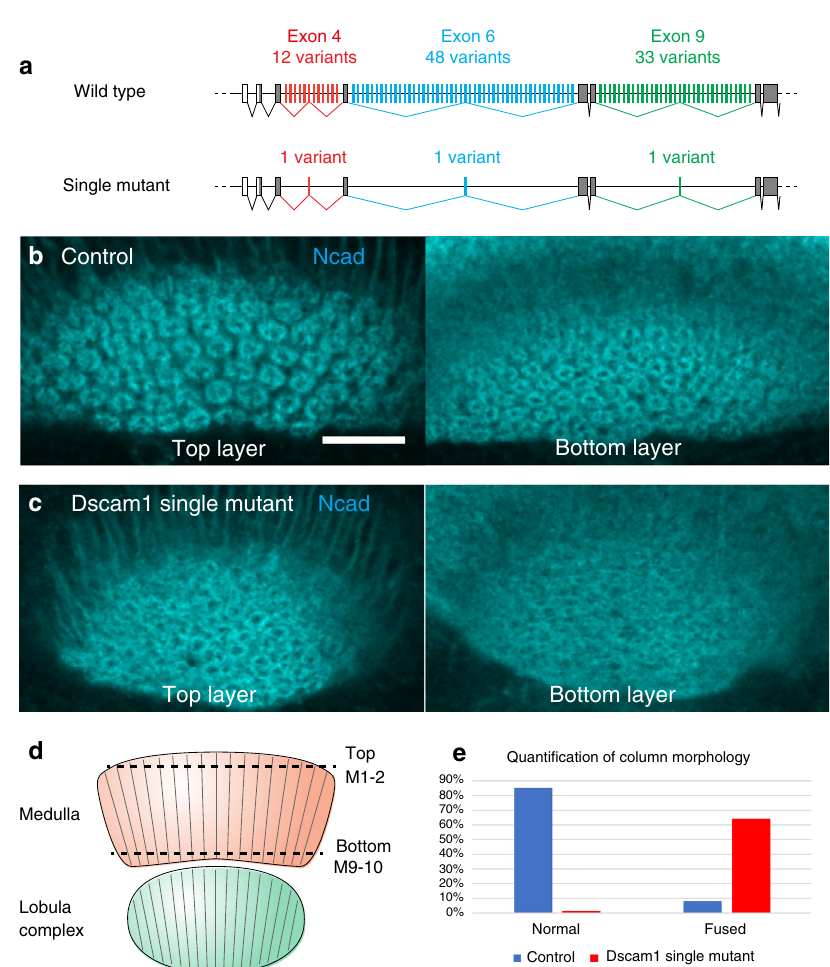
Fig. 6 Loss of Dscam1 isoform diversity leads to defects in column formation. a Schematic representation of Dscam1 gene in wild type and Dscam1 single- isoform mutant backgrounds. Column morphology of 48 h APF pupal medulla visualized by Ncad (blue) in the M1 – 2 (top) and M9 – 10 (bottom) layers in control ( b ) and Dscam1 single mutant backgrounds ( c ; Dscam1 23 /Dscam1 3.31.8 ). Scale bars indicate 20 μ m. Experiment was independently repeated at least three times with similar results ( b , c ). d Schematic representation of the optic lobe at 48 h APF. ( e ) Quanti fi cation of column morphology in the top layer. Control: 74 columns from 5 brains. Single-isoform mutant: 143 columns from 5 brains (Fisher exact text, normal P = 2.11 × 10 − 40 , fused P = 5.4 × 10 − 17 , irregular P = 0.33, unclear P = 0.21). Source data are provided as a Source Data fi